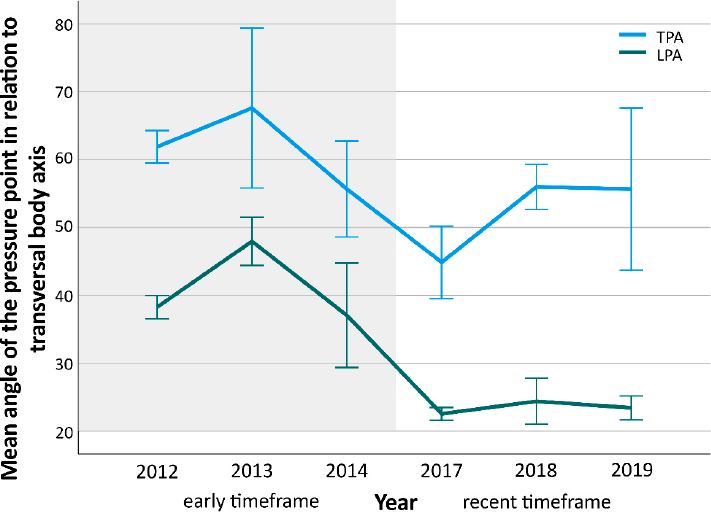
Figure 4. The diagram shows the distribution of mean angles of the lumbar (LPA) and thoracic pressure point angle (TPA) over time. Early timeframe is marked with gray, recent with white background. Mean angle differences between both timeframes were significant (TPA p = 0.011; LPA p < 0.001). Whiskers indicate single standard Table 2. Qualitative brace changes.